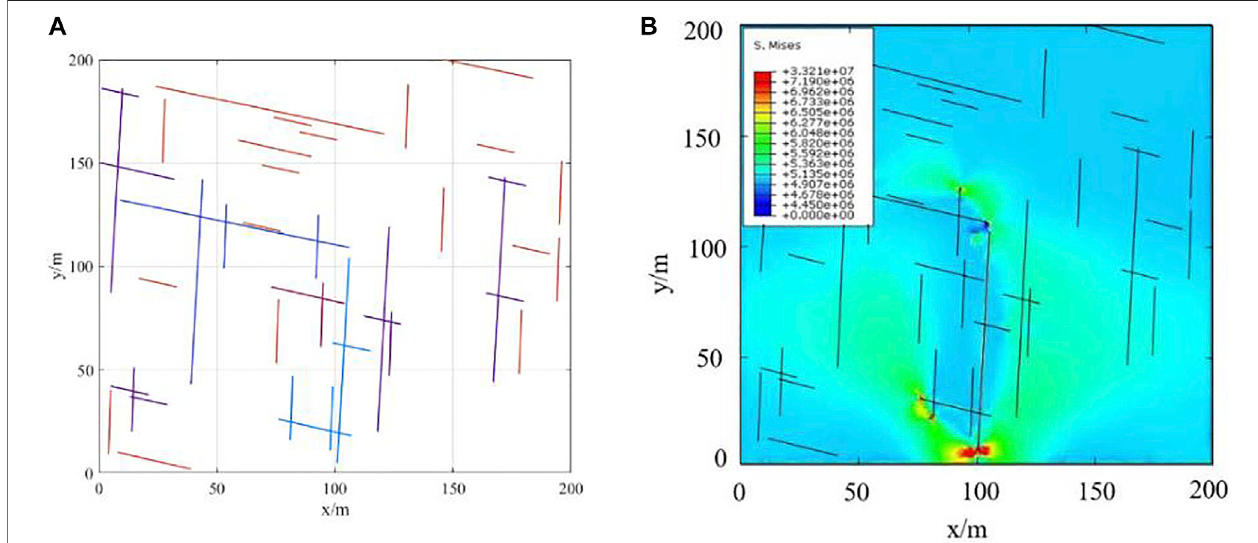
FIGURE 14 | The fracture morphology before and after hydraulic fracturing. (A) The connectivity and fracture distribution of nature fracture. (B) The fracture morphology after hydraulic fracturing.